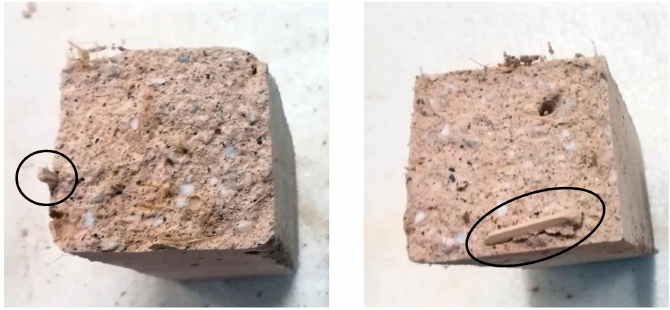
Figure 10. Examples of agglomeration of hemp fibers in tested